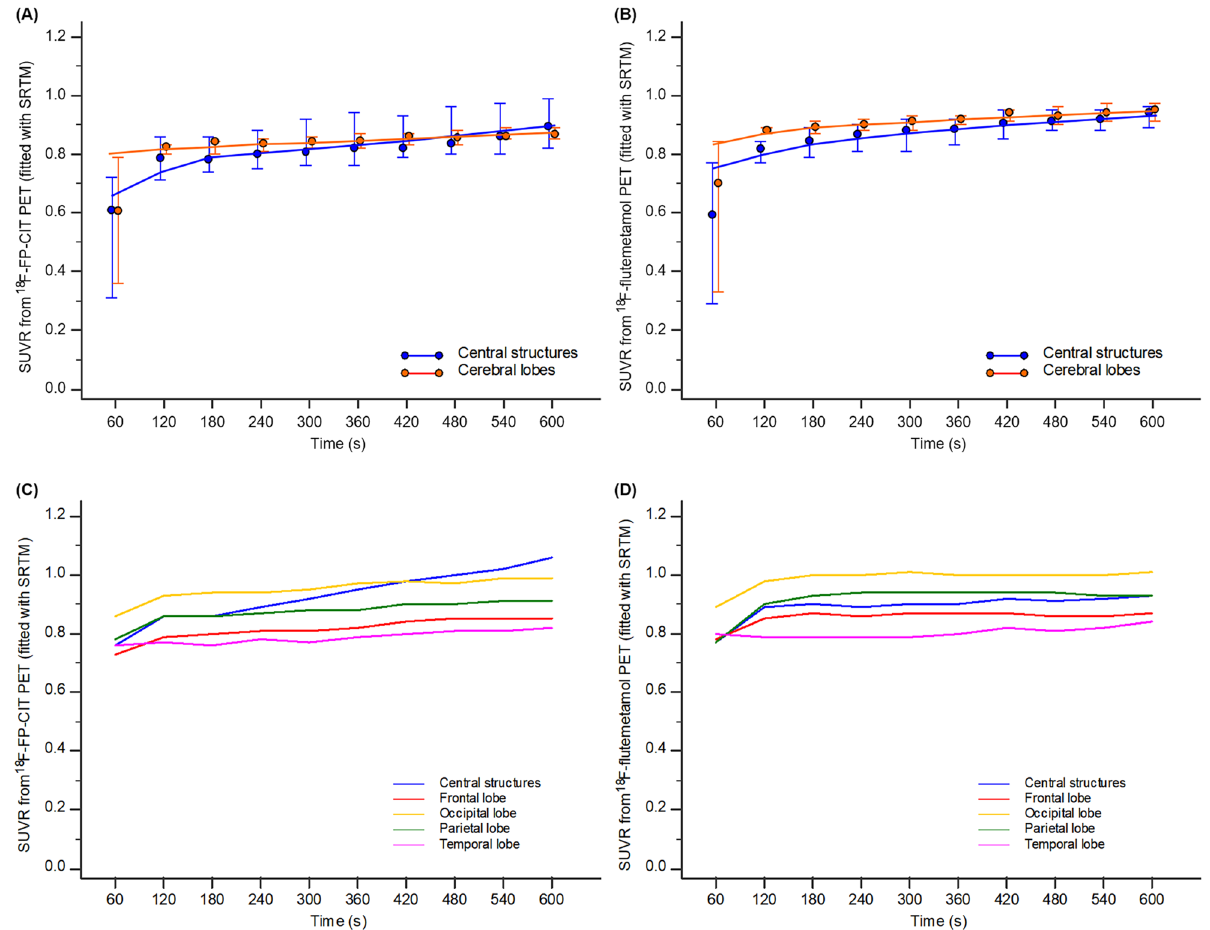
Figure 3. The SUVR time-activity curves (TACs) fitted using the simplified reference tissue method (SRTM) obtained from early-phase 18 F-FP-CIT ( A ) and 18 F-flutemetamol PET ( B ) images. The SUVR of 18 F-FP-CIT in the central structure rose relatively steeply compared to other brain regions after 9 min (blue connecting line in A ). Error bars represent the interquartile range of the median. Typical example of SUVR TACs using SRTM fitting in a patient ( C , D